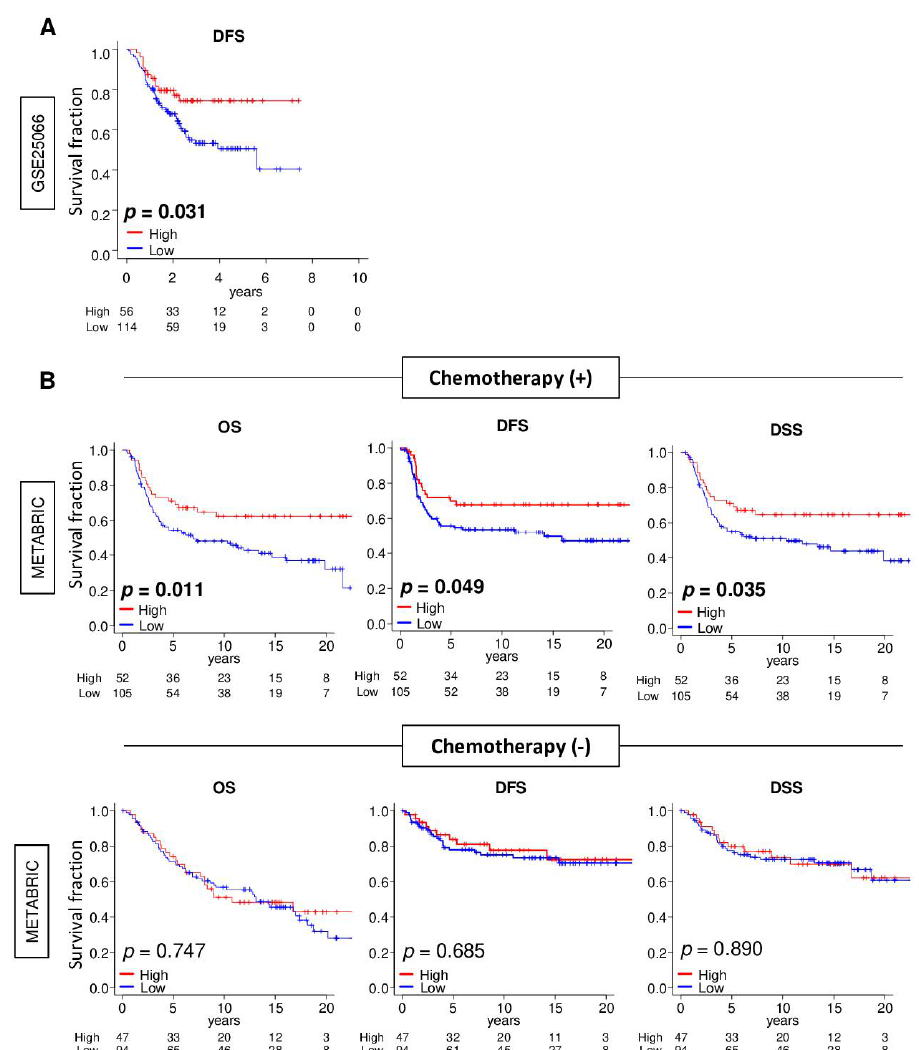
Figure 7. Association between the 3-gene score and the survival of patients with triple-negative breast cancer (TNBC) with or without chemotherapy. ( A ) Kaplan–Meier plots of comparison between low (blue line) and high (red line) 3-gene score groups for disease-free survival (DFS) in the GSE25066 cohort. ( B ) Kaplan–Meier plots of the comparison between low and high 3-gene score groups for overall survival (OS), DFS, and disease-specific survival (DSS) in the treatment group and non-treatment group in the METABRIC cohort. The top one-third was defined as the high-score group within the cohort. The log rank test was used to calculate the p values.